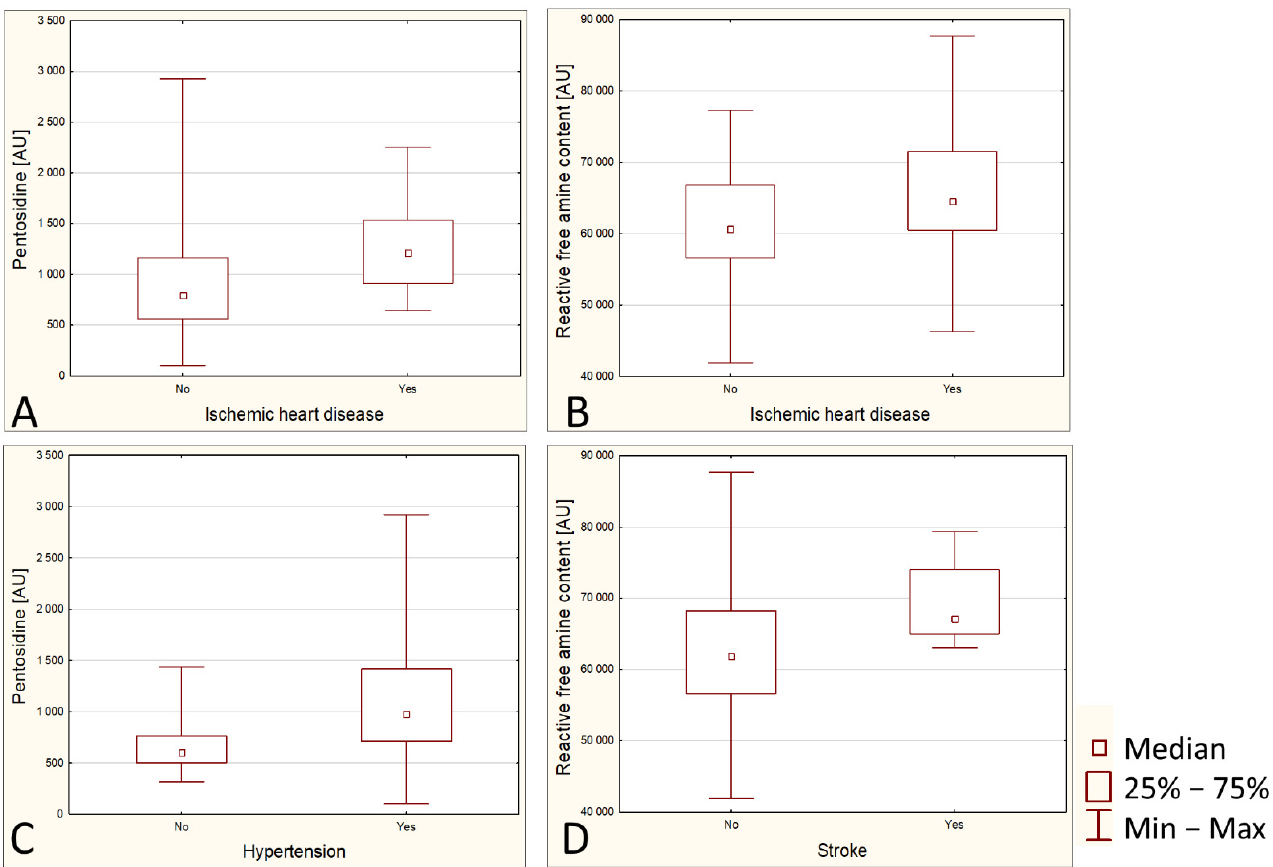
Figure 2. Group comparison between variables (box and whisker plots). Comparison of pentosidine (panel A ) and reactive free amine content (panel B ) in patients with and without ischemic heart disease. Comparison of pentosidine (panel C ) in patients with and without hypertension. Comparing the level of reactive free amine content in patients with and without stroke (panel D ).